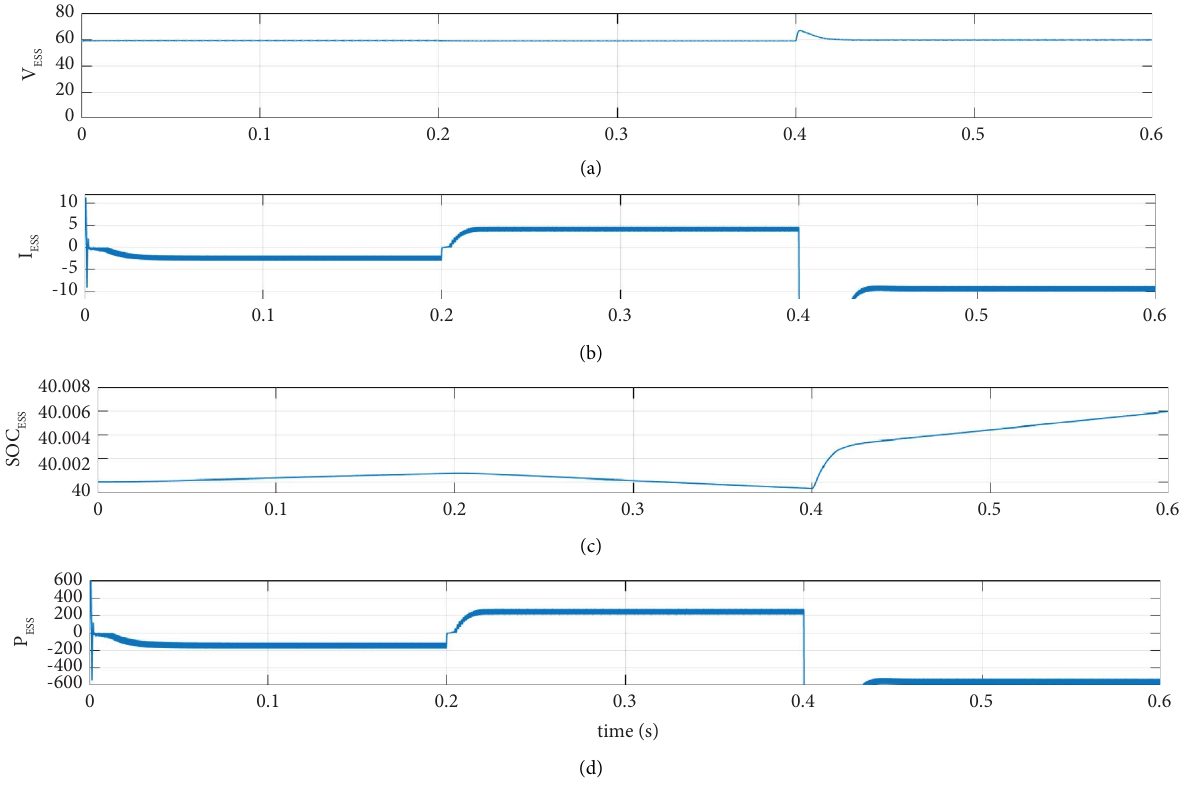
Figure 12: Simulation results (a) ESS voltage (b) ESS current (c) ESS SOC (d) ESS